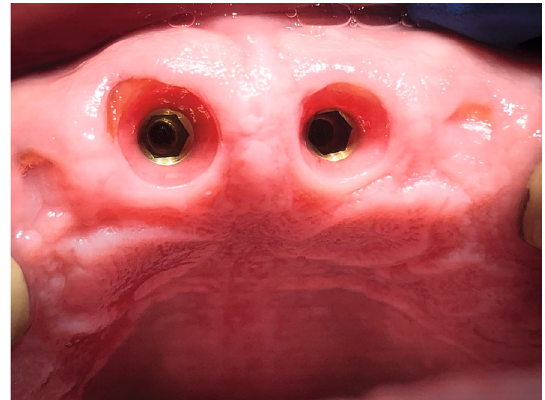
Figure 8: Shield exposure on 1.1